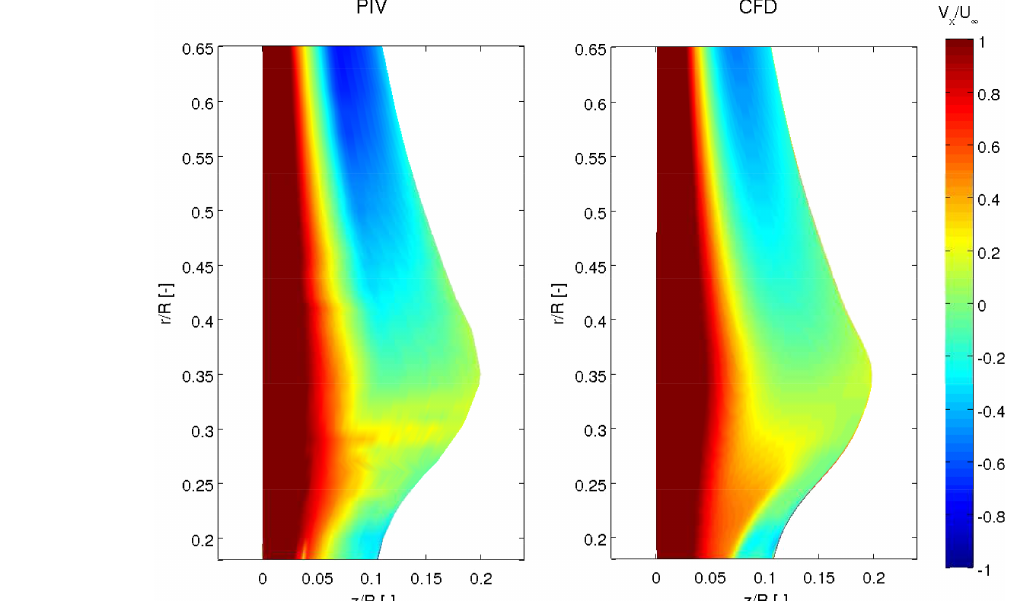
Figure 9. Experimental and numerical results of the axial velocity component 10mm off the blade suction